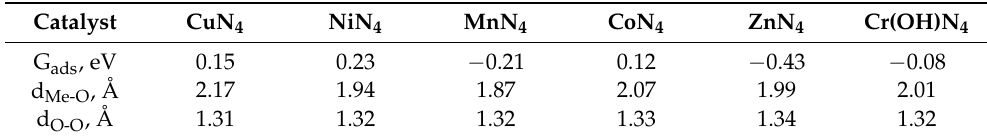
Table 1. Energies of molecular oxygen adsorption.